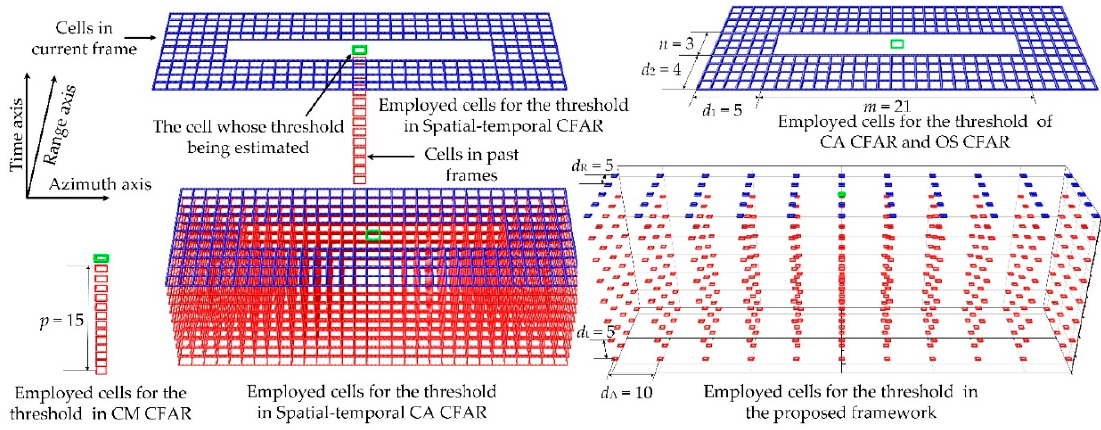
Figure 7. The employed cells for the detection threshold in mentioned approaches.